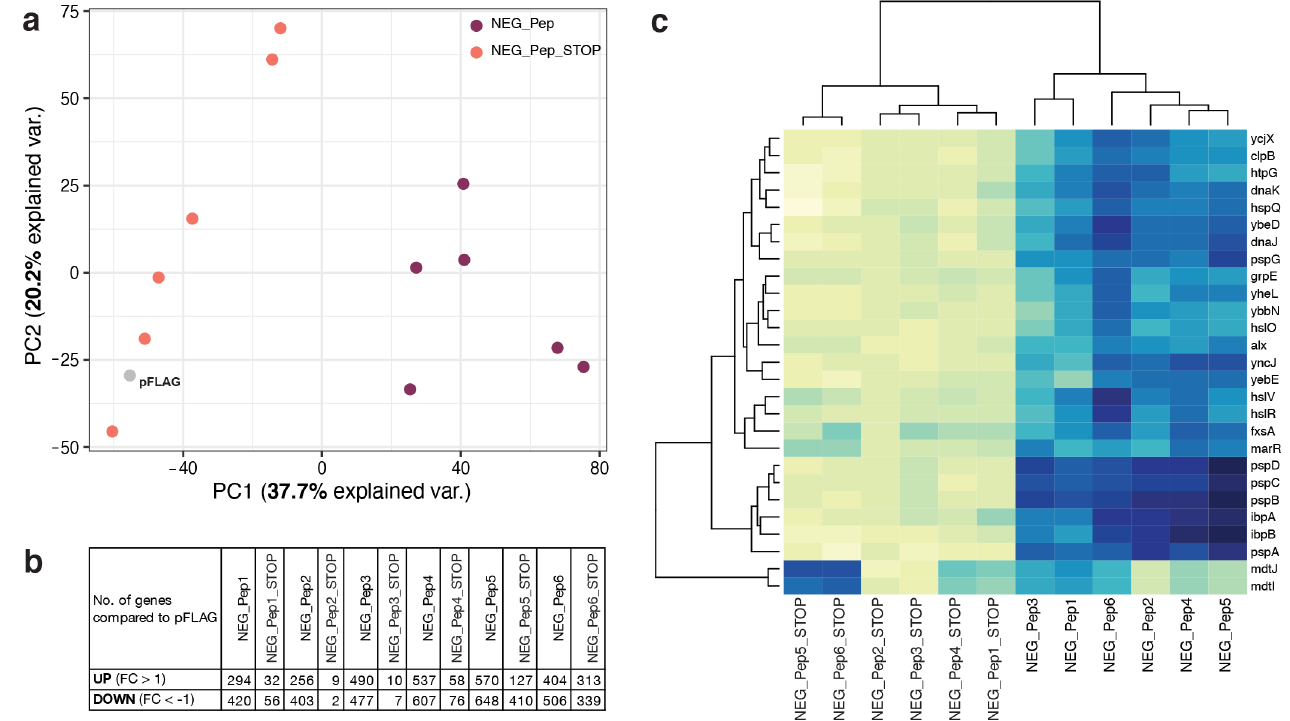
Figure 4. Transcriptomes of host cells expressing NEG_Pep clones show differential up-regulation of genes compared to their stop codon versions. ( a ) Principal component analysis (PCA); dots represent average expression from three replicates for each sample. ( b ) Numbers of genes above and below log2 fold change (FC) of 1 and ‒ 1 are shown here respectively. ( c ) Top highly expressed genes in all NEG_Peps are represented in the heatmap with dendrograms highlighting the differential expression in their corresponding stop codon versions. The x -axis shows the sample names and y -axis lists the top expressed genes (log2 FC > 4) from the expression analysis.